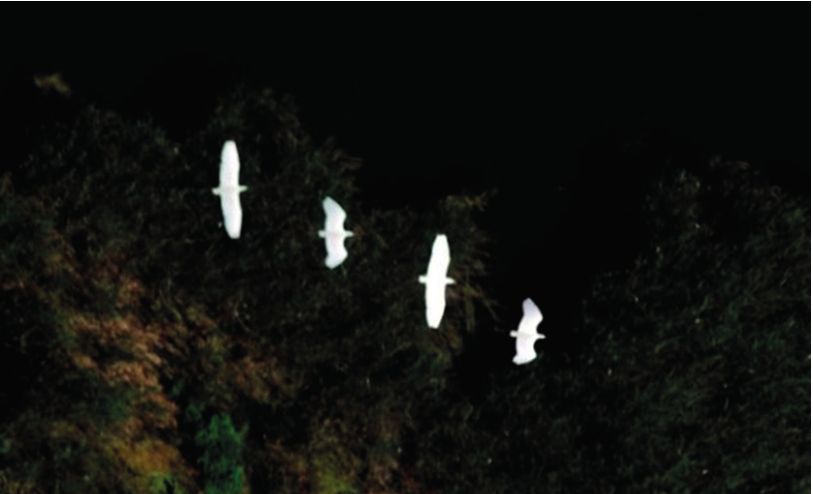
Figure 8. The flight progress of a great white egret in four consecutive images. However, an image is not counted if the plane returns within 0.5 min on the next flight line. The continuous recording also illustrates the flight of the